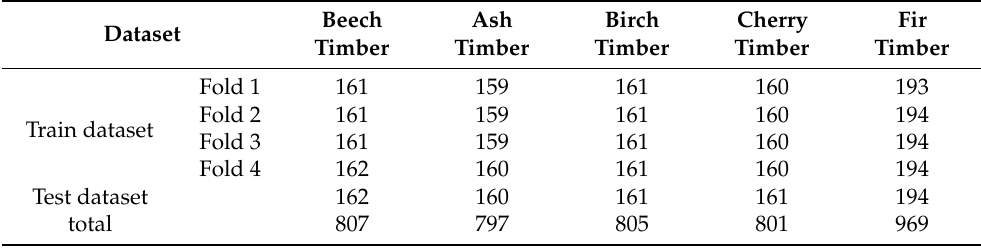
Table 2. Distribution of sawn timber sample data using 4-fold cross validation method.